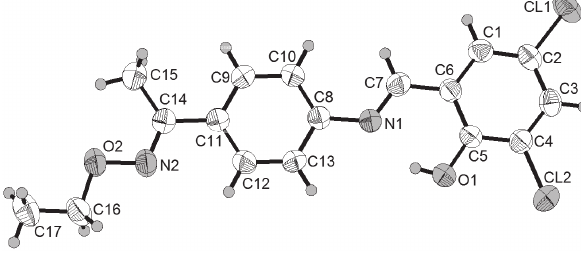
Table 1: Data collection and handling.